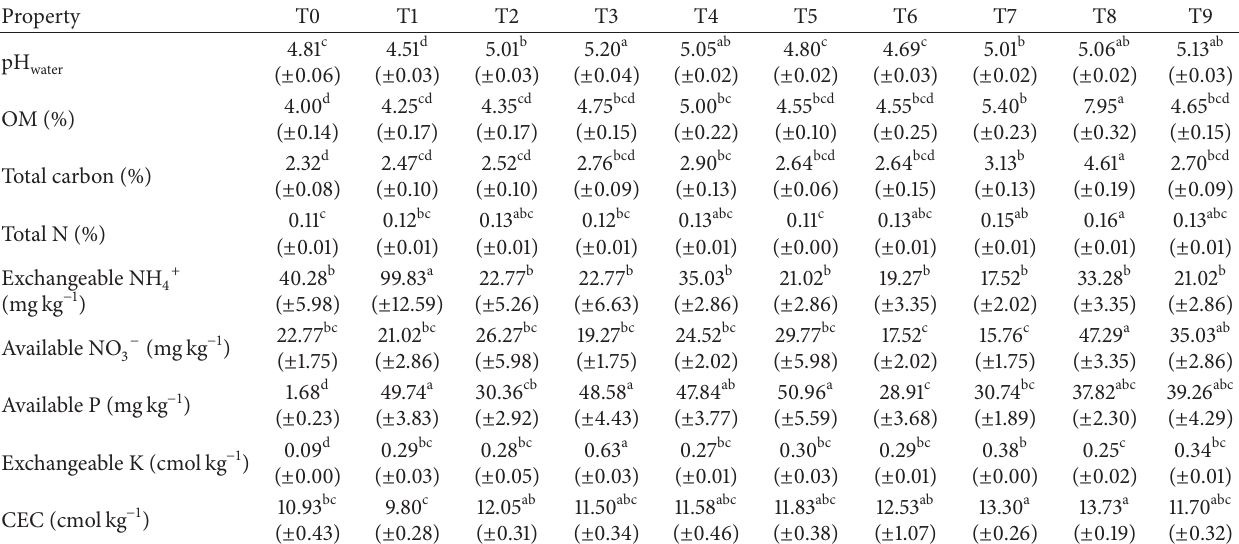
Table 9: Selected soil chemical properties at 48